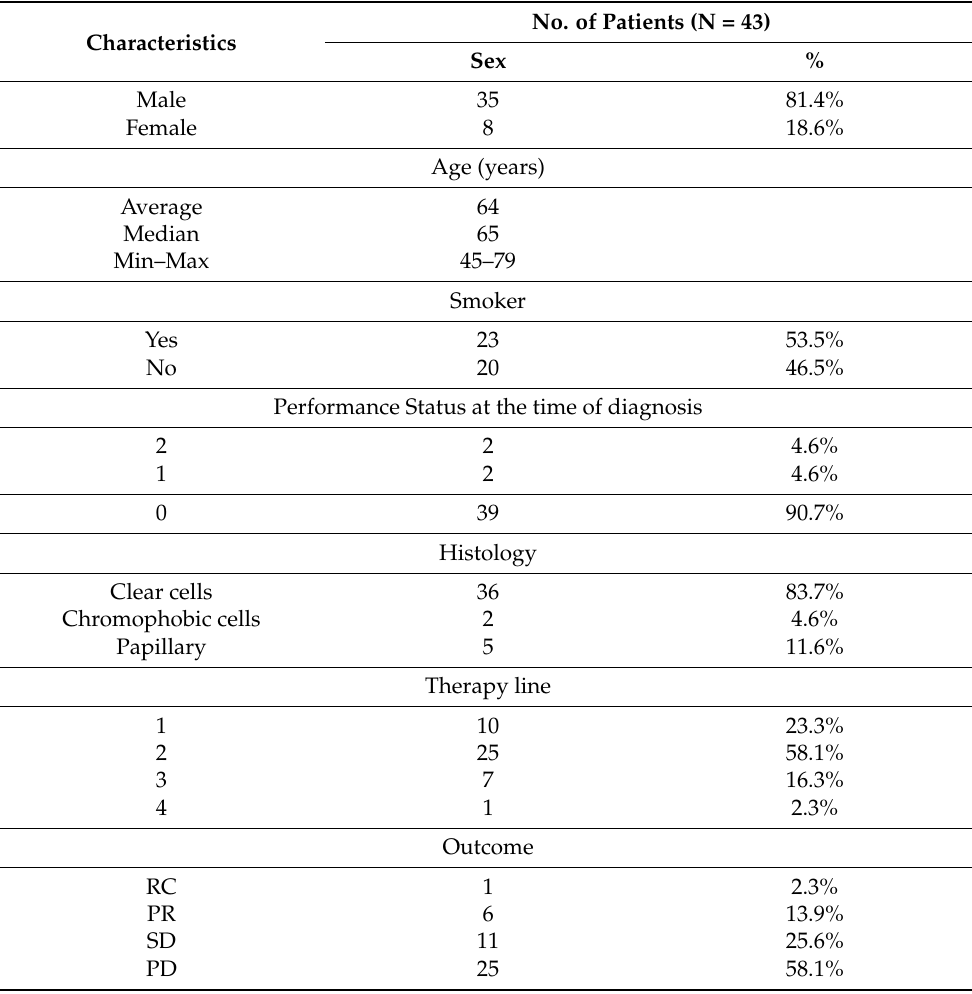
Table 1. Clinical features of the study population.